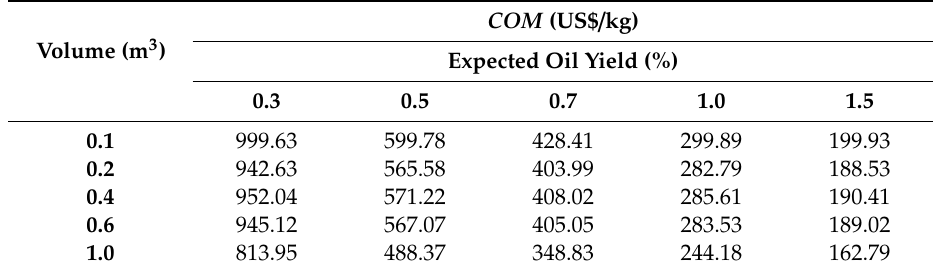
Table 12. Manufacturing cost of a supercritical extract of Pistacia lentiscus leaves, in a batch of 60 min (220 bar and 40 °C).